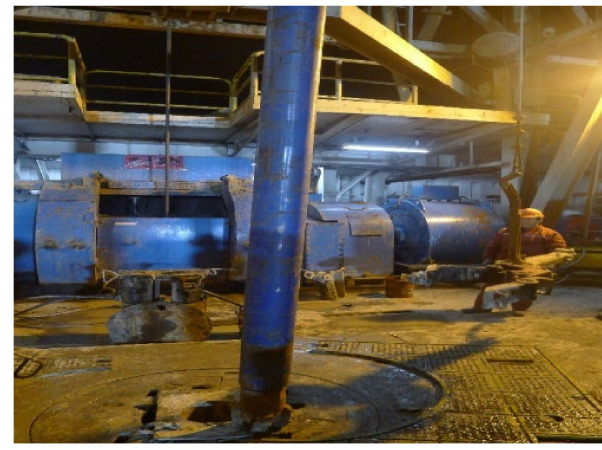
Figure 3. Device downhole experiment. (1)